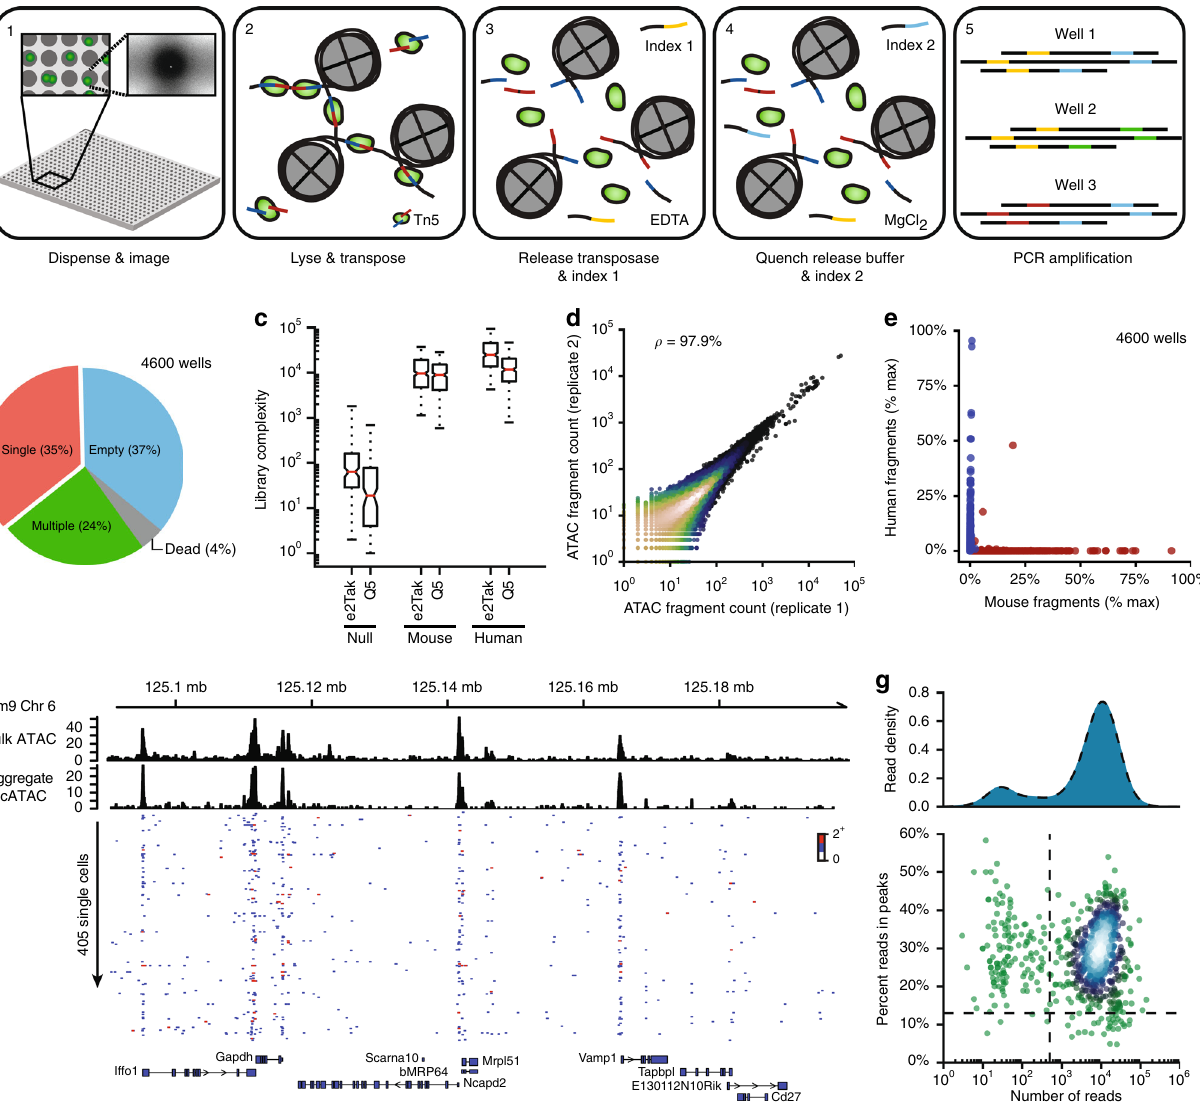
Fig. 1 µ ATAC-seq: a nano-well scATAC-seq implementation on the ICELL8 platform. a µ ATAC-seq work fl ow. b Distribution of cell counts per well measured by fl uorescence microscopy (Hoechst). c µ ATAC-seq library complexity for null, mouse, and human targeted wells using two separate polymerases (e2Tak and Q5) for well barcoding and ampli fi cation ( n = 5000 wells). For each sample, the box denotes the interquartile range centered at the median (red line), while the whiskers span the 5th and 95th percentile range. d Correlation between nano-well chips processed with either a e2Tak (replicate 1) or Q5 polymerase (replicate 2) across all accessible loci. e Inter-well mixing of mouse and human µ ATAC-seq fragments. f Representative population 22 and single-cell ATAC-seq genome tracks for the Gapdh locus. g Signal-to-background (percent reads in peaks) as a function of read depth ( n = 792). Only cells lying in the upper right quadrant (marked by dashed lines) are retained for downstream